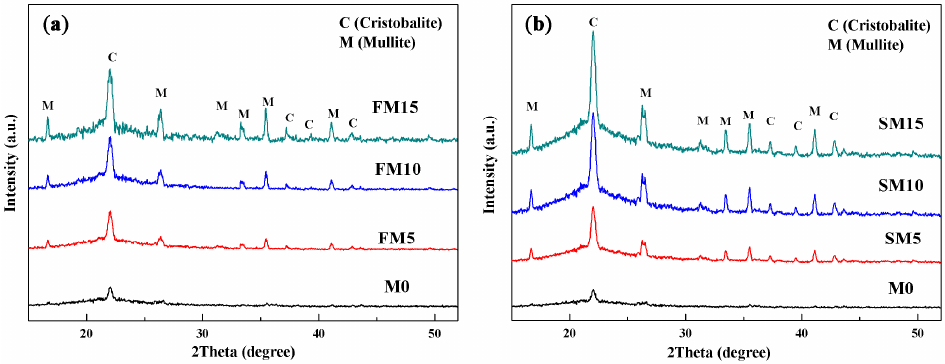
Table 3. Mass fraction (wt.%) of the phases in different ceramic cores.